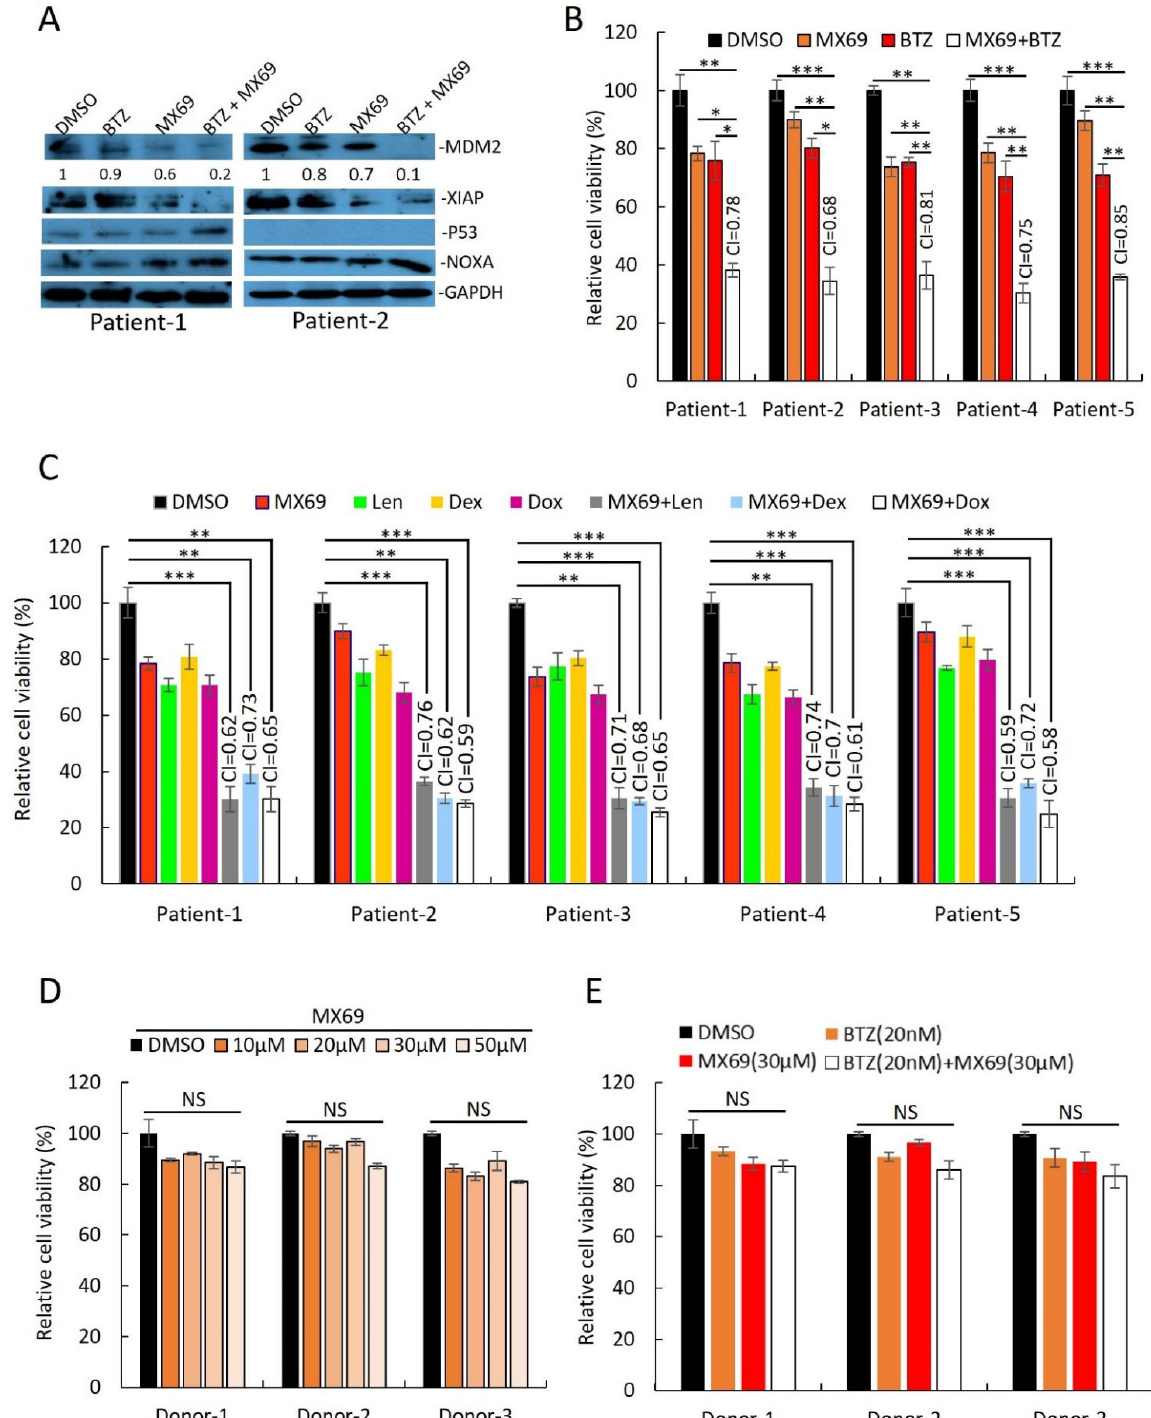
Figure 4. Combination of MX69 with anti-myeloma drugs show synergistic effects on MM patient samples. ( A ) Western blot of cell lysates from MM patient PBMCs after 48 h treatment with DMSO or single/combination treatment with 20 μM MX69 and 10 nM BTZ. MDM2 protein densitometry measured through normalized GAPDH. The uncropped blot is in Supplemental Figure S15. ( B , C ) Cell viability of CD138+ cells from MM patients after 48 h treatment with DMSO or single/combination treatment with 20 μM MX69, 10 nM BTZ 5 μM Len, 10 μM Dex , and 1 μM Dox. Results are presented as mean ± SD of three independent experiments. ( D ) Cell viability of normal donor PBMCs after 48 h treatment with DMSO or different concentrations of MX69, as indicated. Results are presented